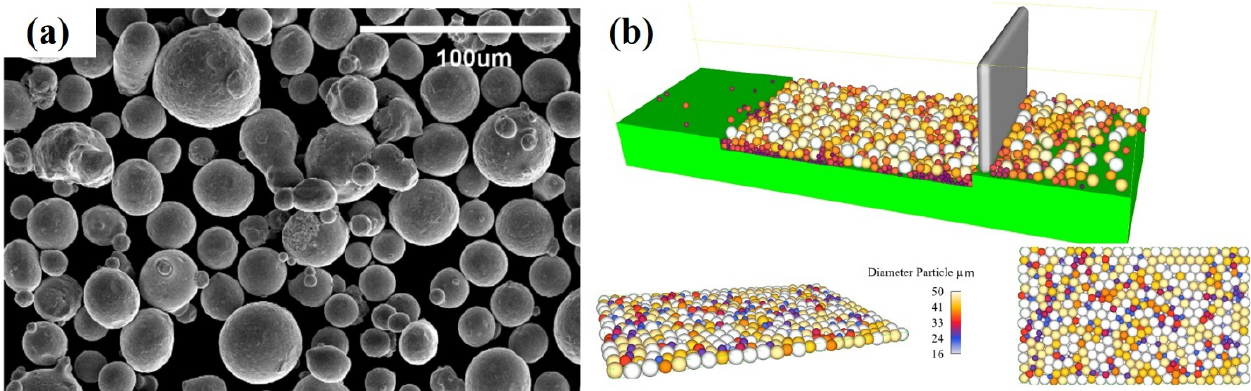
Figure 2. ( a ) Scanning electron microscopy images of Ti6Al4V powder particles and ( b ) simulated powder bed using discrete element modelling.